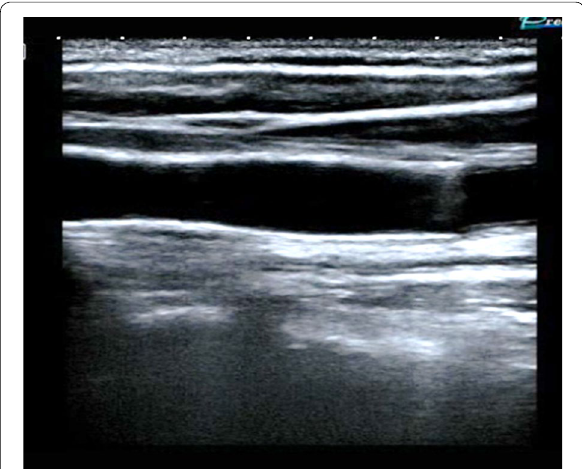
Fig. 3 Color Doppler Imaging of carotid demonstrating turbulent flow in the posterior wall pseudoaneyrysm